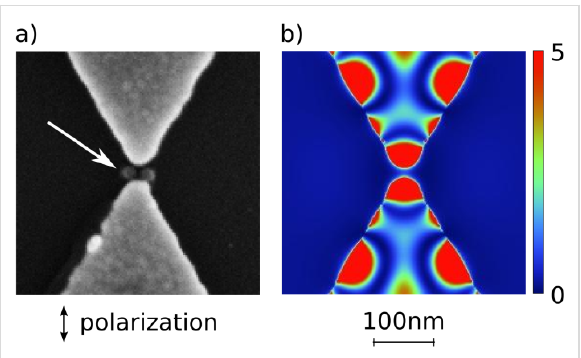
Figure 13: (a) SEM micrograph and (b) calculated field distribution for the center region of a bow-tie antenna with a distance of 30 nm. The structure has been irradiated with a 150 fs laser pulse (wavelength: 800 nm) with a local fluence of 90 mJ/cm 2 . The arrow points towards the region in the feed gap where ablation of the Si has taken place. The color scale in (b) has been chosen such to show the field distribu- tion in the region between the